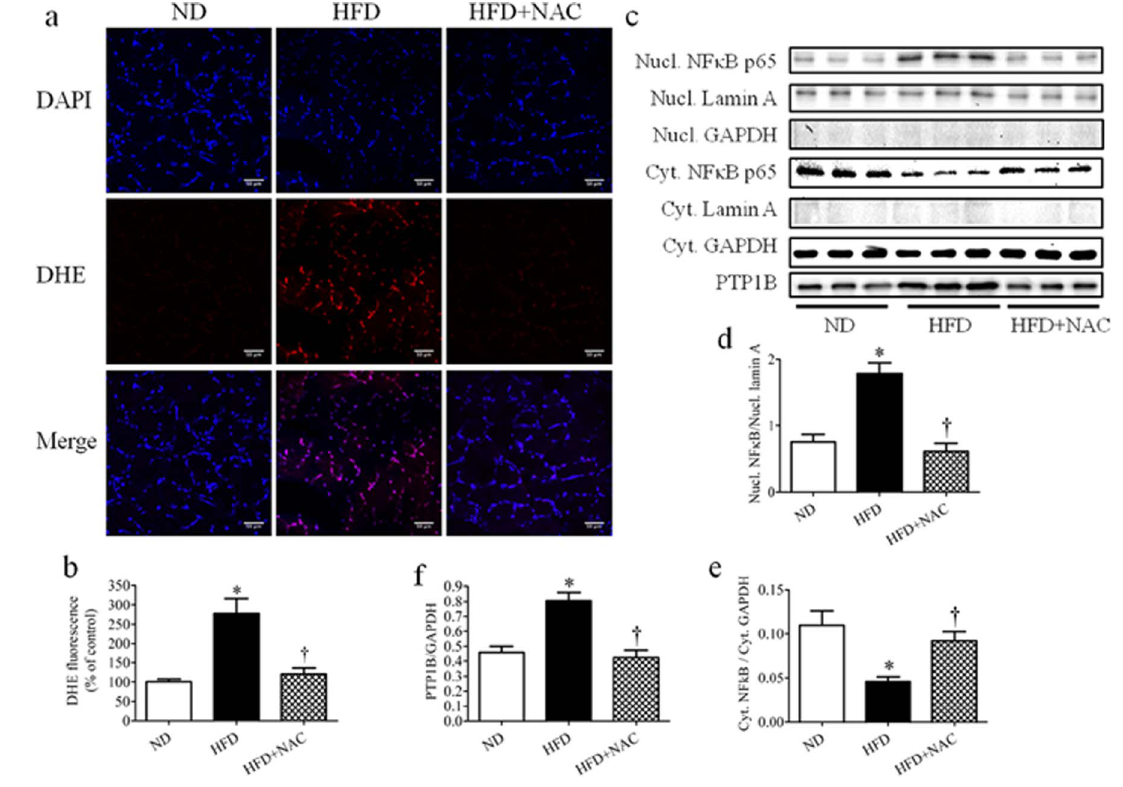
Figure 9. The role of ROS and NF k B in high-fat diet-induced PTP1B expression in skeletal muscle. Gastrocnemius muscles were isolated from C57 or PTP1BKO mice received normal (ND) or high-fat content (HFD) in a presence or absence of NAC supplementation diets for 3 weeks. (a–b) Representative confocal microscopy pictures (a) and quantification (n=6) (b) of intracellular ROS production. ROS detection dye DHE is shown as red, the nucleus is stained with DAPI (blue), with purple suggests colocalization. Scale bars, 50 m m. (c–f) Representative Western blots (c) and densitometric analysis (n=6) of nuclear NF k B (Nucl. NF k B) (d), cytosolic NF k B (Cyt. NF k B) (e), and PTP1B (f) protein expression. * p , 0.05 compared with C57 ND mice, { p , 0.05 compared with C57 HFD mice.